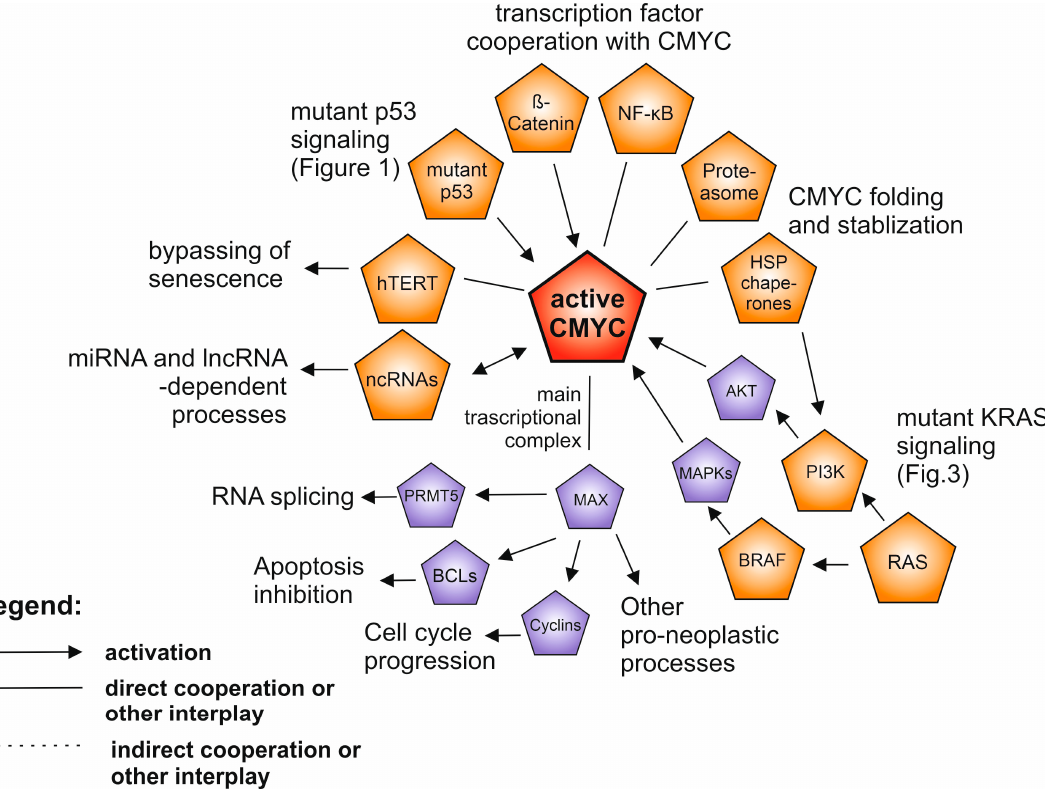
Figure 2. The network of the interplay between activated CMYC (highlighted in red) and other oncogenic drivers in human neoplasia. The drivers described in separate paragraphs are shown in orange, while additional oncoproteins are shown in purple. Only the selected, well supported connections are shown, described in the text.